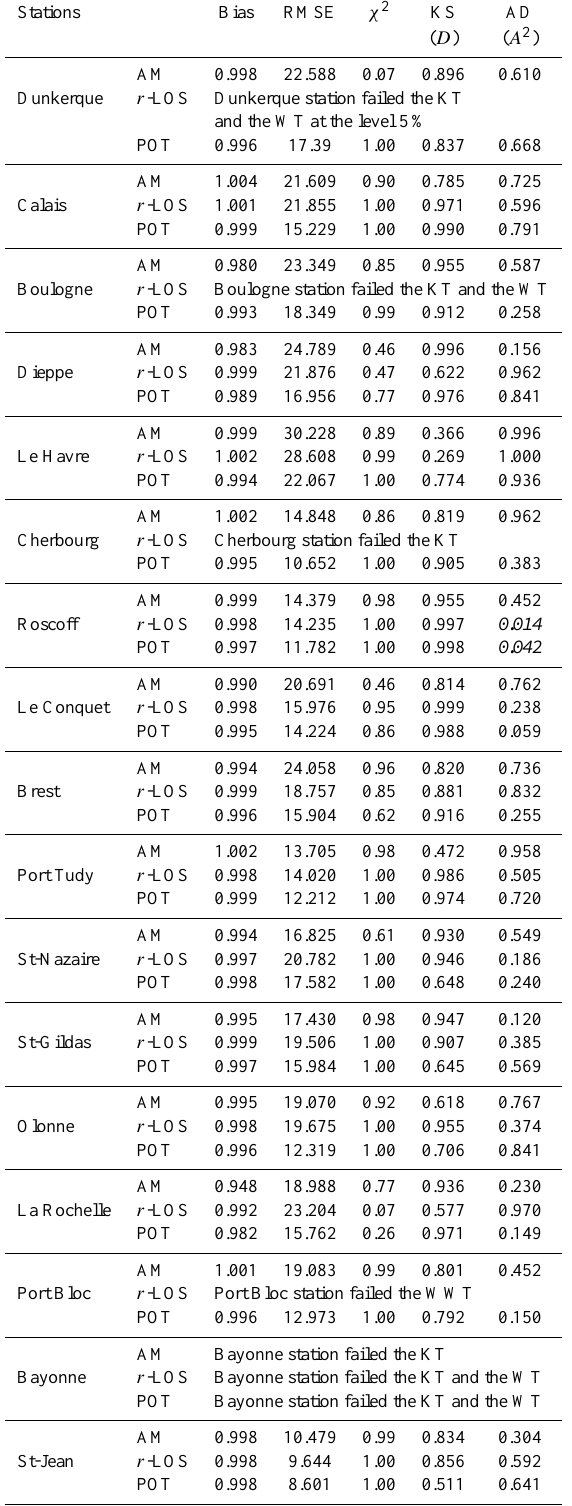
Table 3. Adequacy criteria and test using AM, r -LOS and POT data sets (with optimum choice of r and u